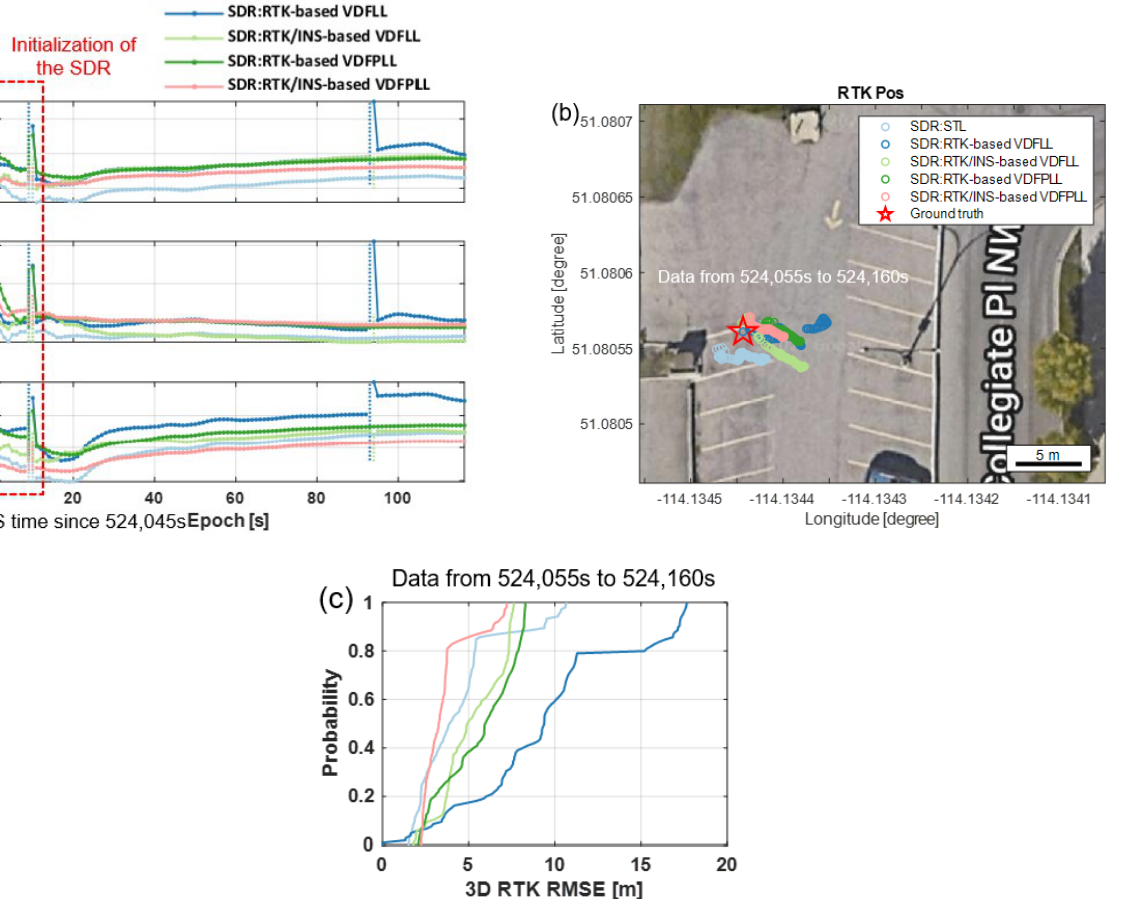
Figure 13. RTK position results and statistical analysis of different SDRs in the semi-open-sky situation where dashed lines correspond to the outlier epochs. ( a ) RTK position error ( b ) horizontal RTK position results in Google Map ( c ) CDF curves of 3D RTK